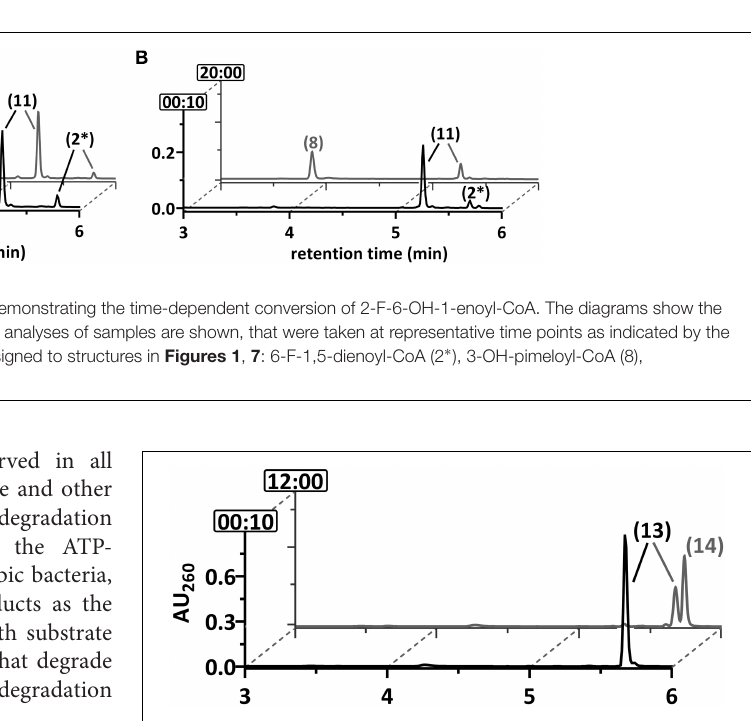
FIGURE 6 | Ultraperformance liquid chromatography diagrams demonstrating the time-dependent conversion of 2-Cl-BzCoA by BCR+DCH and OAH. UPLC analyses of samples are shown, that were taken at representative time points as indicated by the numbers (min) at the y -axis. Peaks of CoA ester compounds are numbered as follows: 2-Cl-BzCoA (13), Cl-1,5-dienoyl-CoA